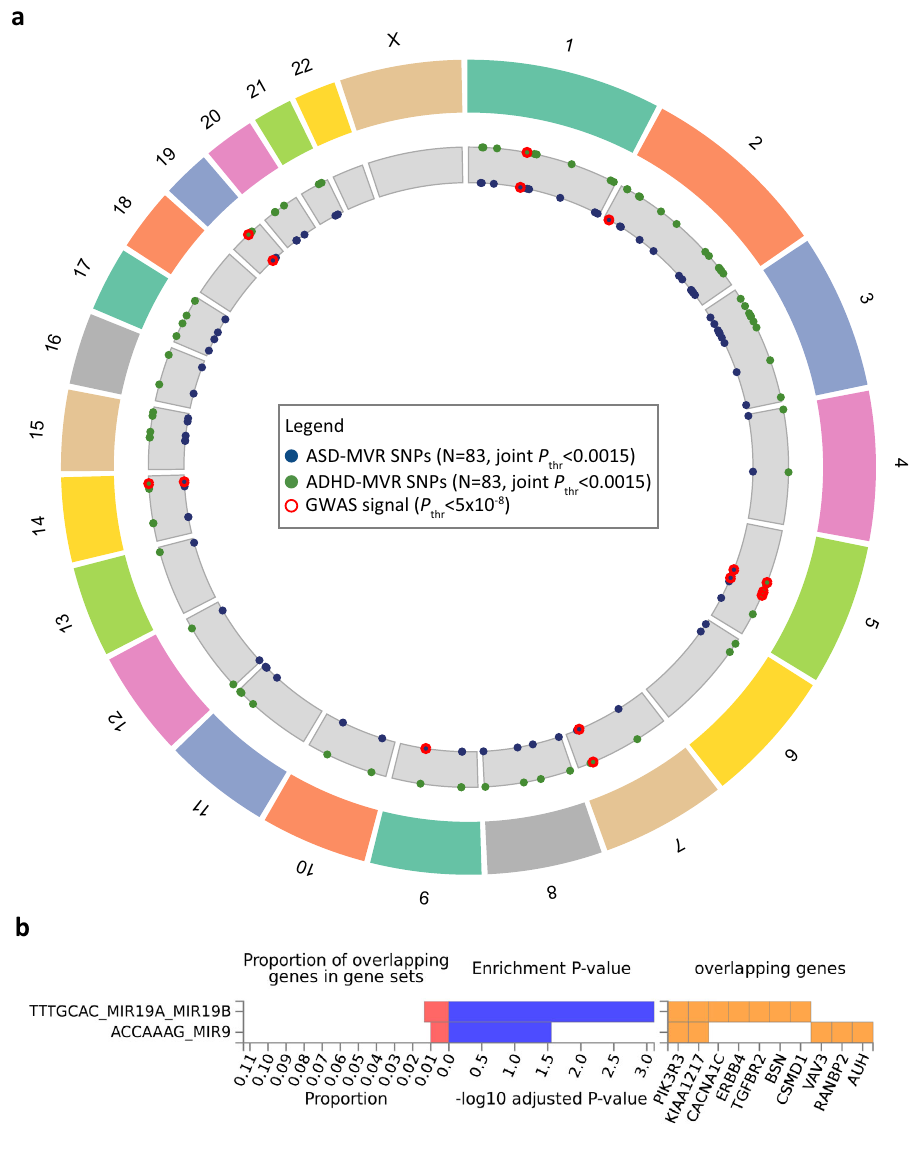
Fig. 5 Characterisation of loci (N = 83) contributing to polygenic pleiotropy. ( a ) Chromosomal position and ( b ) functional enrichment for micro-RNA targets of variants selected at a joint P -value threshold for both ASD and ADHD ( P thr < 0.0015). For enrichment analyses variants were mapped to 52 genes, and, of those, 45 were aligned to unique Ensembl IDs (v92) and subjected to gene-set enrichment analysis (requesting at least 5 overlapping